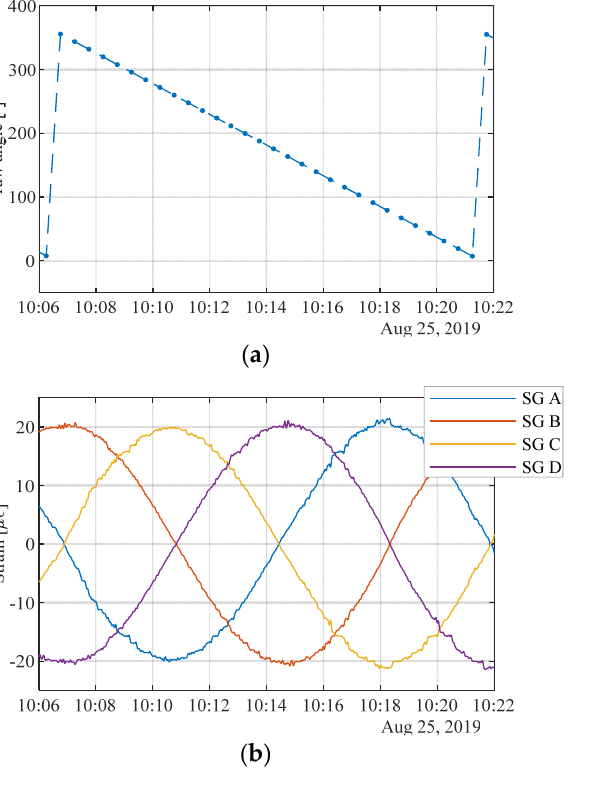
Figure 7. Strain-gauge calibration check: ( a ) yaw angle nacelle; ( b ) strain signals; and ( c ) mean value of the full rotation signals observed from February 2019 to April 2020 (see sensor positions in Figure 4c).